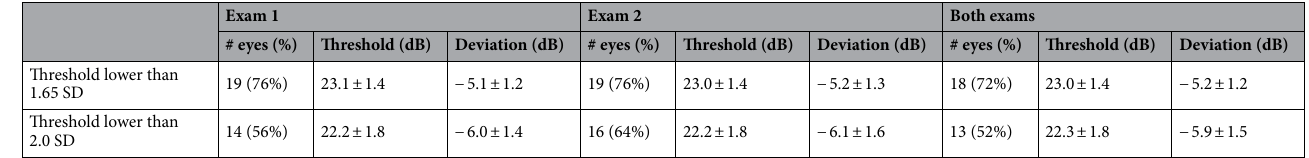
Table 2. The number of iAMD eyes out of the cohort of 25 eyes with at least 5 abnormal points using 2 criteria for abnormality, and the average threshold and deviation of these